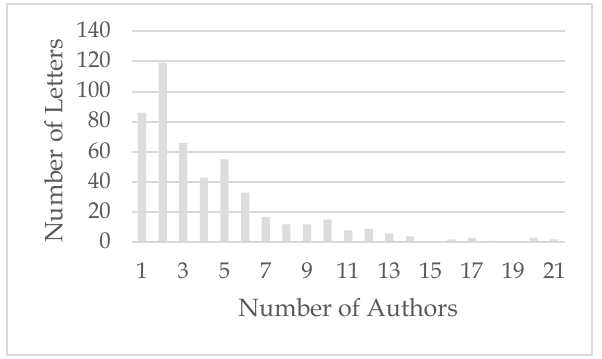
* Excludes one Letter with 35 authors.